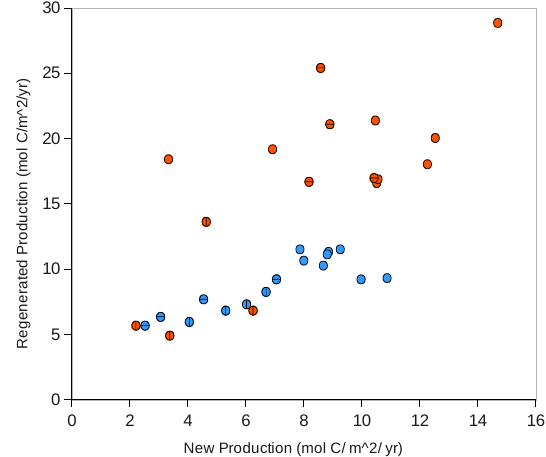
Fig. 12. The relationship between the regenerated production and the new production in the California CS (blue) and Canary CS (or- ange). Data were averaged over the 100km wide nearshore area and over 1 ◦ bins in meridional direction. Circles with horizontal lines correspond to the southernmost part of each system, i.e., from 30 ◦ N to 34 ◦ N for the California CS and from 12 ◦ N to 16 ◦ N for the Canary CS, and circles with vertical lines indicate their north- ernmost parts, i.e., from 42 ◦ N to 46 ◦ N for the California CS and from 24 ◦ N to 28 ◦ N for the Canary